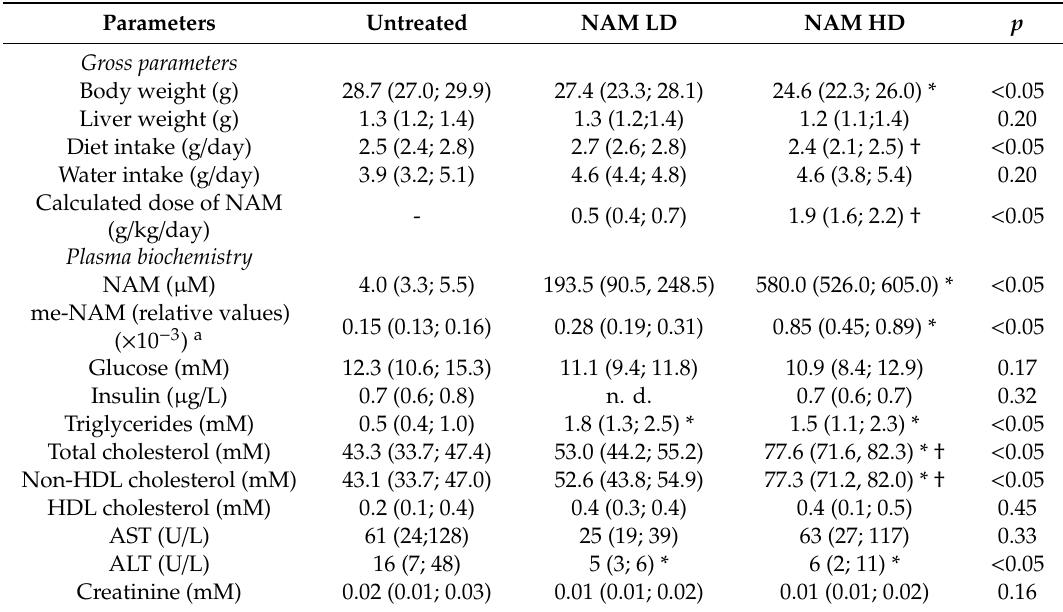
Table 1. E ff ect of NAM administration on gross parameters and plasma biochemical parameters of male ApoE-deficient